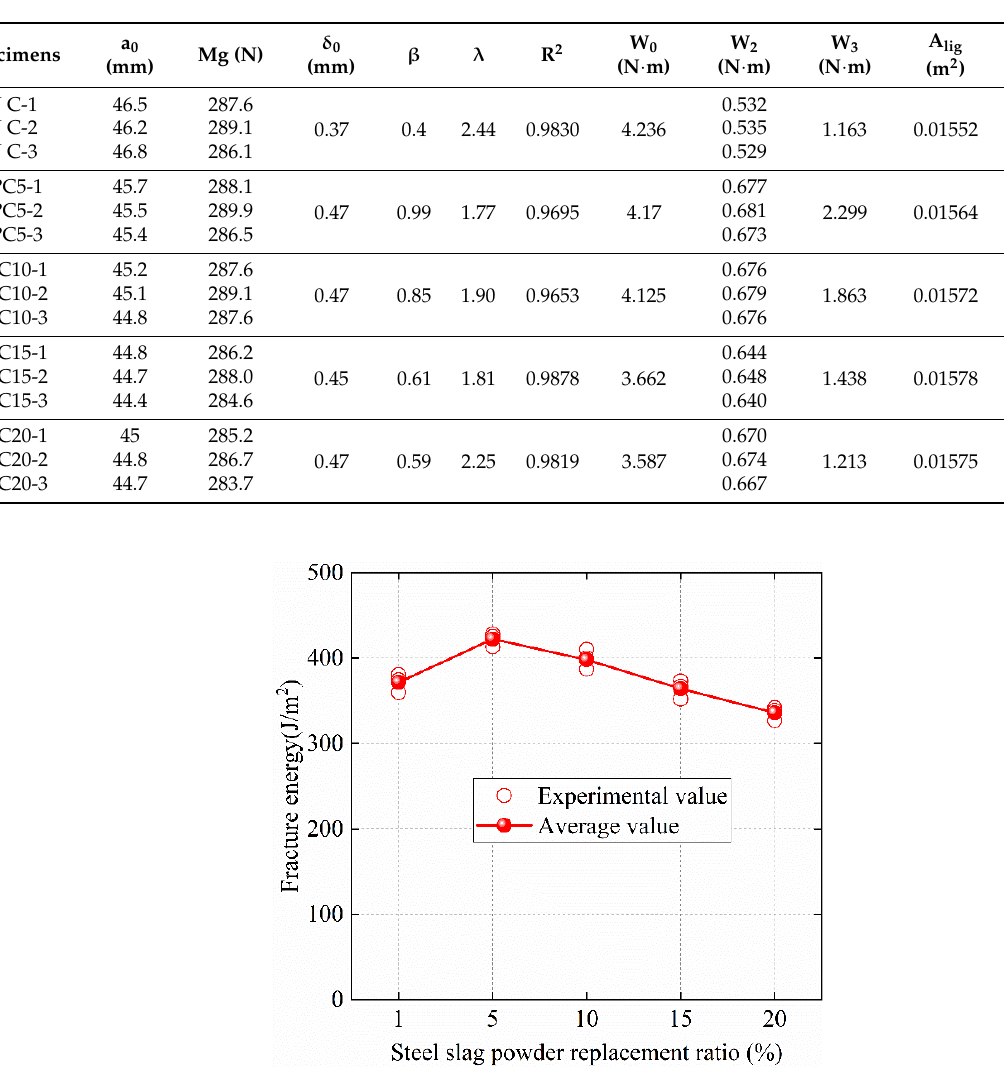
Figure 5. Load-deflection (P- δ ) curves. Table 3. Values of fracture energy of concrete of SFC.